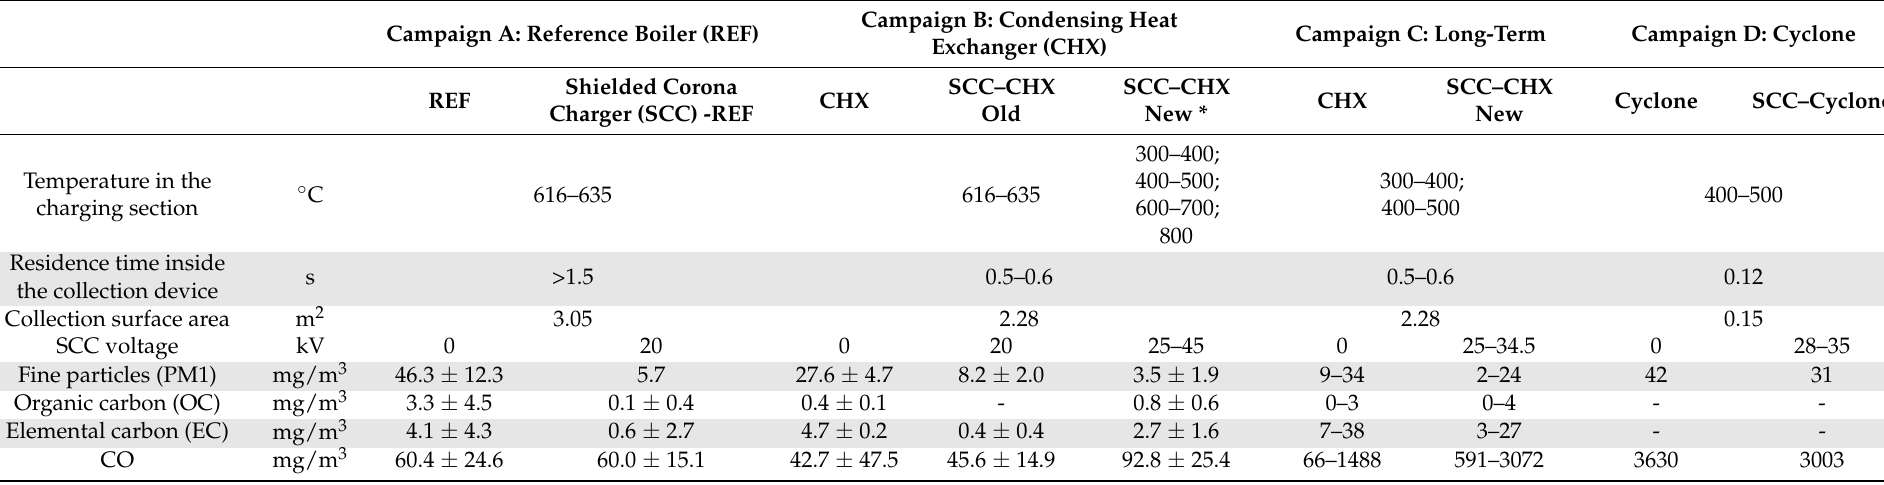
Table 1. Measurement campaigns with different shielded corona charger (SCC) and condensing heat exchanger (CHX) setups. Campaign A includes experiments with a conventional boiler setup and with CHX setup, in which the effects of SCC were studies as described in a previous study [23]. Campaign B, “SCC–CHX new”, consists of a series of measurements where the effects of the SCC operating conditions were studied. Campaign C includes a series of long-term experiments with CHX and CHX–SCC setups. In campaign D the effect of SCC on the particle reduction efficiency of a cyclone was studied. The data are reported as averages with standard deviations, or as a range of typical values if the variance is